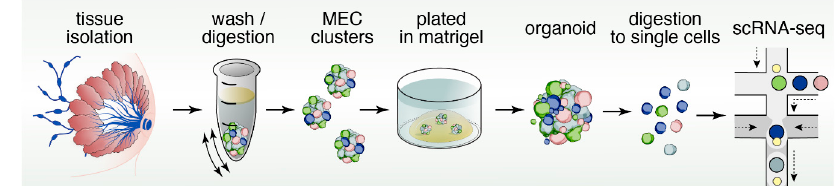
Figure 6. Organoids, scRNAseq, and other technologies to resolve cellular heterogeneity. Combination of different platforms such as organoids and scRNAseq but also mouse models, lineage tracing, and patient-centric assays will likely each make important contributions to resolve cellular heterogeneity in the mammary gland and in breast cancer.